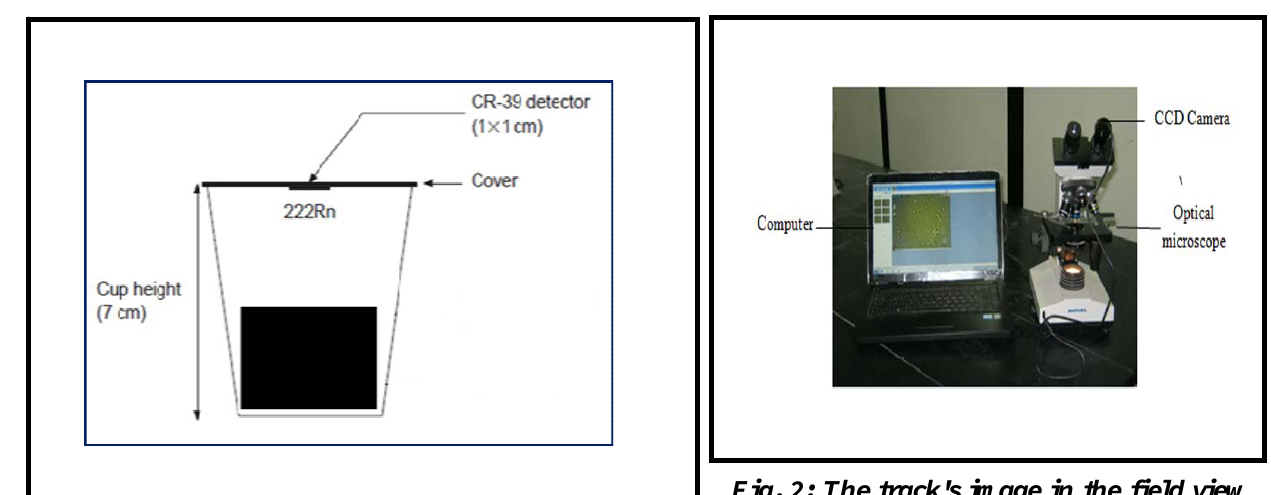
Fig. 1: Schematic diagram showing the geometry of radon dosimeter used in the